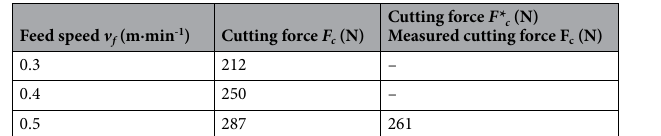
Feed speed v f (m·min -1